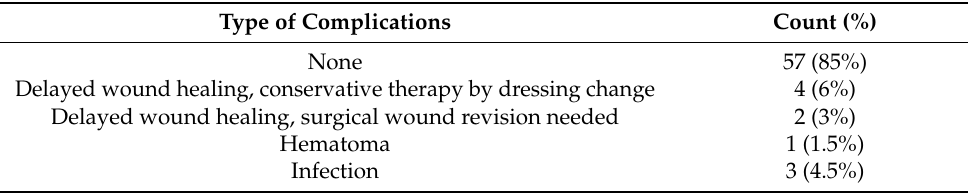
Table 2. Complication rate ( n = 10; (15%))—computed with respect to the total number of operated breasts ( N =